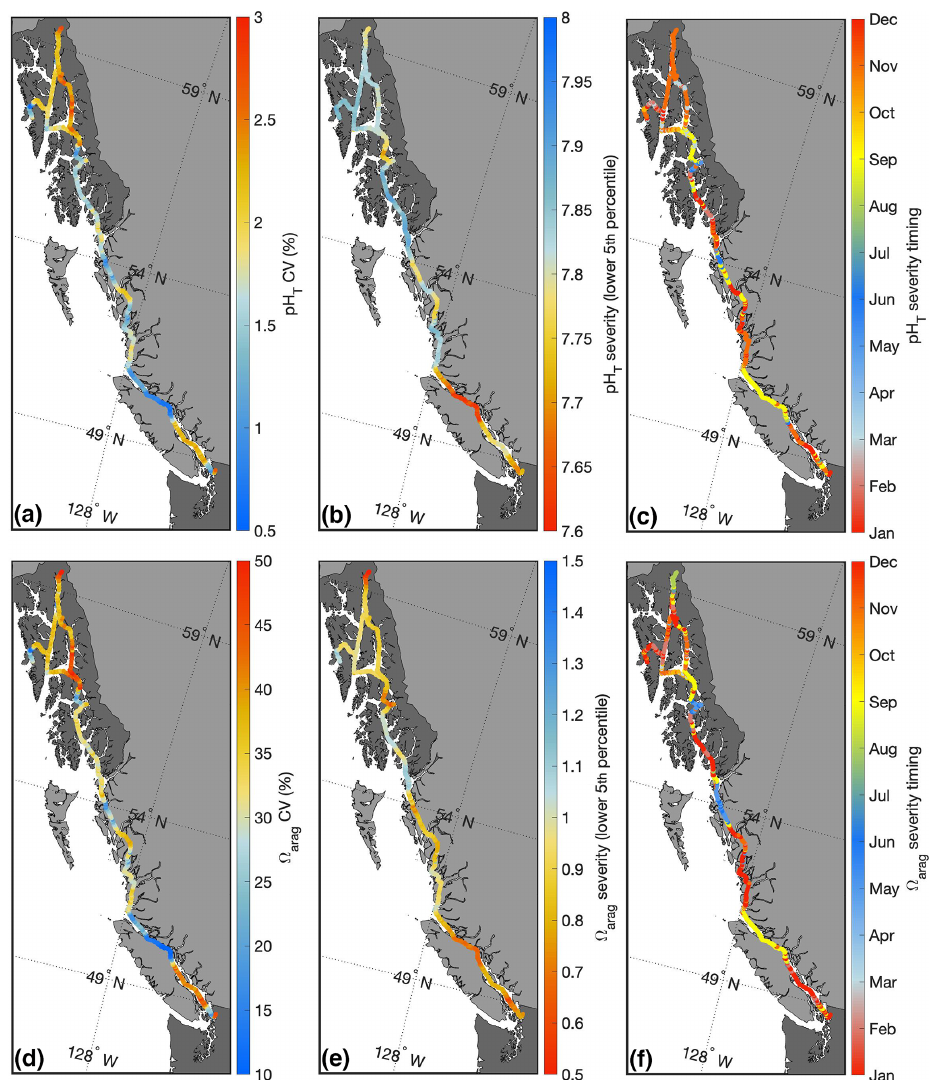
Figure 6. Panels (a–c) show the pH T coefficient of variation (CV), severity, and the timing of severe pH T conditions, respectively. Panels (d–f) show the same parameters for (cid:127) arag